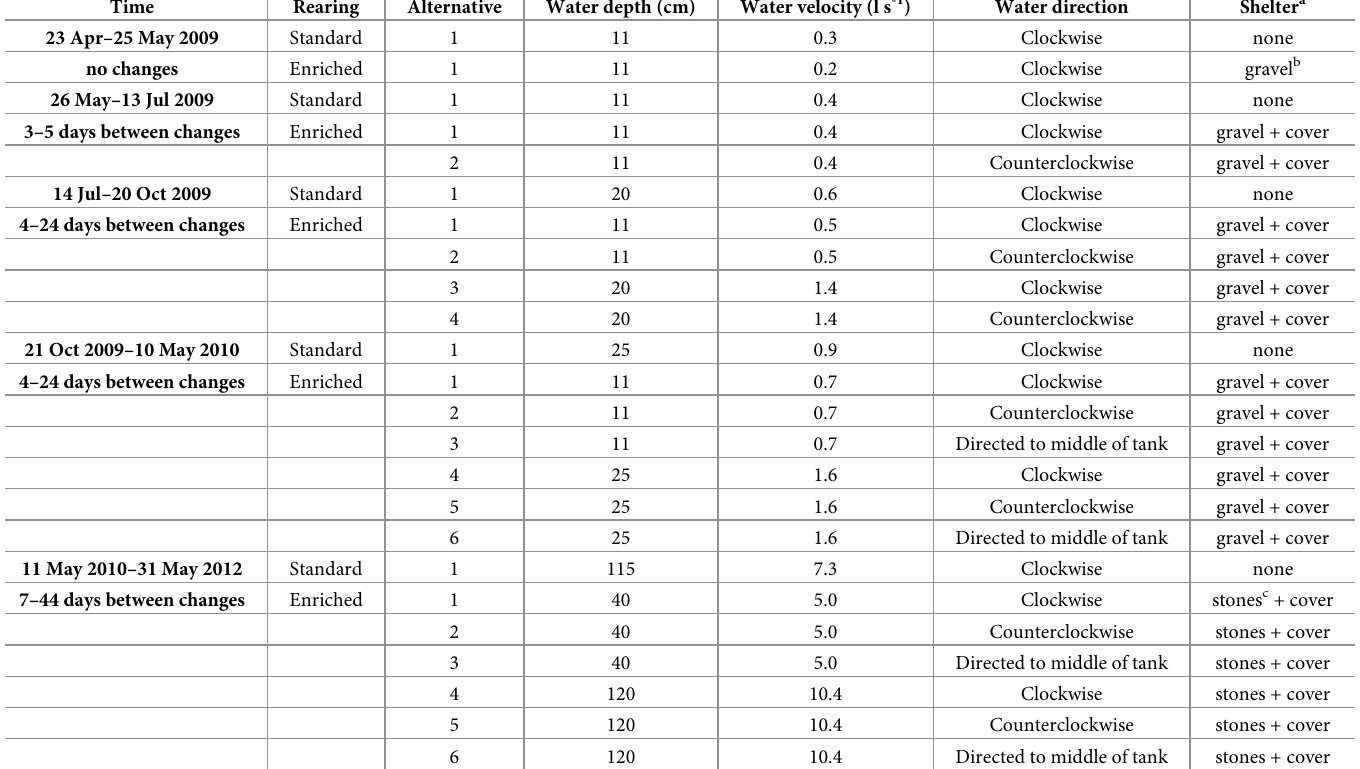
Table 2. Water depth, velocity and direction changes, and shelter structures used for the enriched rearing. There was no variation in these factors for the standard rearing. Time